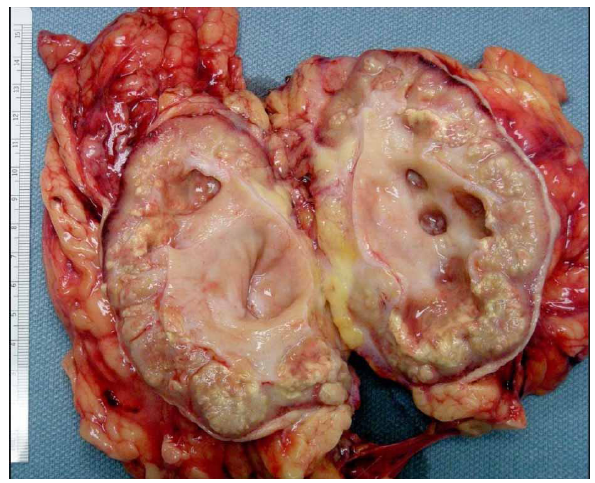
Figure 1: Gross photograph showing nephrectomy specimen with poor corticomedullary differentiation, dialated renal pelvicalyceal system with deposition of yellowish specks lim- ited to the renal parenchyma and sparing perinephric fat in XGP patient.